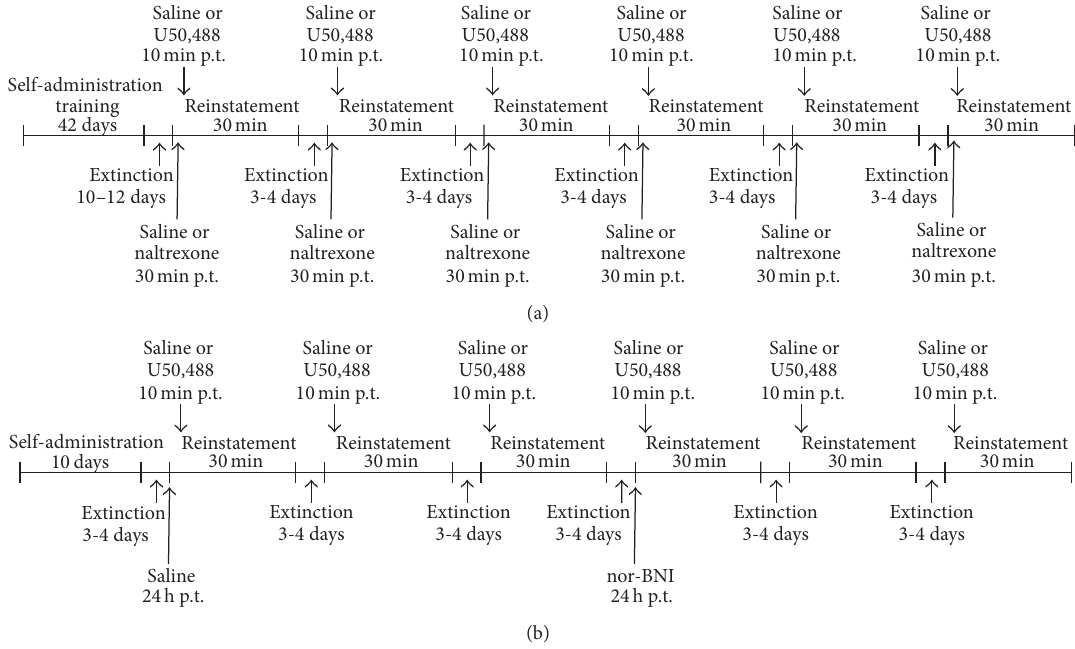
Figure 2: (a) Experimental timeline for naltrexone antagonism of U50,488-induced reinstatement. Rats ( 𝑛 = 13 ) were trained to self- administer ethanol, and then lever pressing was extinguished. Following extinction, rats were pretreated with naltrexone (3.0mg/kg, s.c.) or saline 30 min prior to testing. Rats were then injected with U50,488 (0.1–1.0 mg/kg, i.p.) or saline 10 min prior to testing. Test sessions were conducted every 3-4 days, with rats experiencing extinction sessions daily between test days. (b) Experimental timeline for nor-BNI antagonism of U50,488-induced reinstatement. Stable self-administration levels were reestablished following the experiment described in (a) and then extinguished. Following extinction, rats were pretreated with a single saline injection. 24 h later rats were injected with a U50,488 (0.1–1.0mg/kg, i.p.) or saline 10 minutes prior to testing. Test sessions were repeated every 3-4 days with rats experiencing extinction sessions daily between test days. After all doses of U50,488 were tested, rats were given a single injection of nor-BNI (20mg/kg, i.p.). 24 h later, rats were injected with U50,488 (0.1–1.0 mg/kg, i.p.) or saline 10 minutes prior to testing. Test sessions were repeated every 3-4 days with rats experiencing extinction sessions daily between test